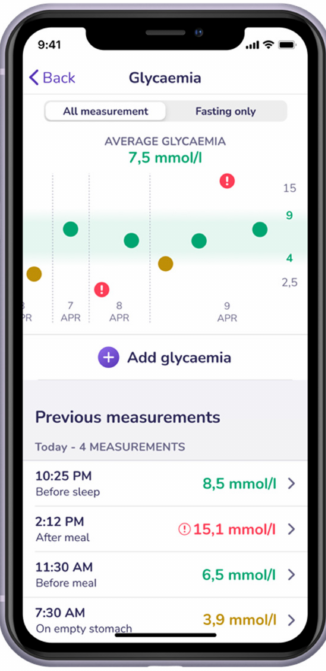
Figure A4. Glycemic values overview.